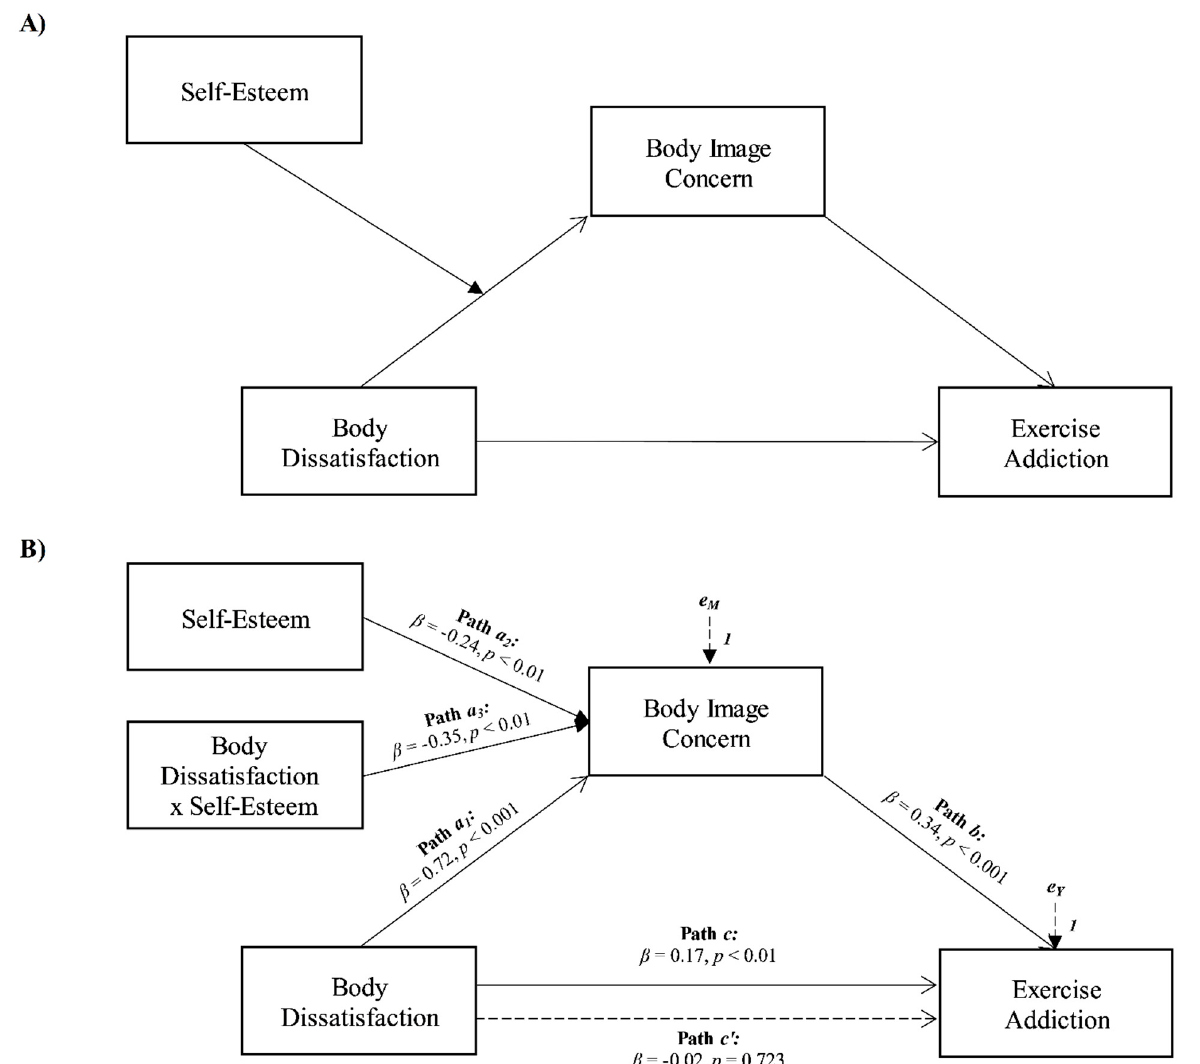
Figure 3. Statistical ( A ) and conceptual ( B ) forms of Model 3: a moderated mediation involving body dissatisfaction, body image concern, and self ‐ esteem toward exercise addiction.